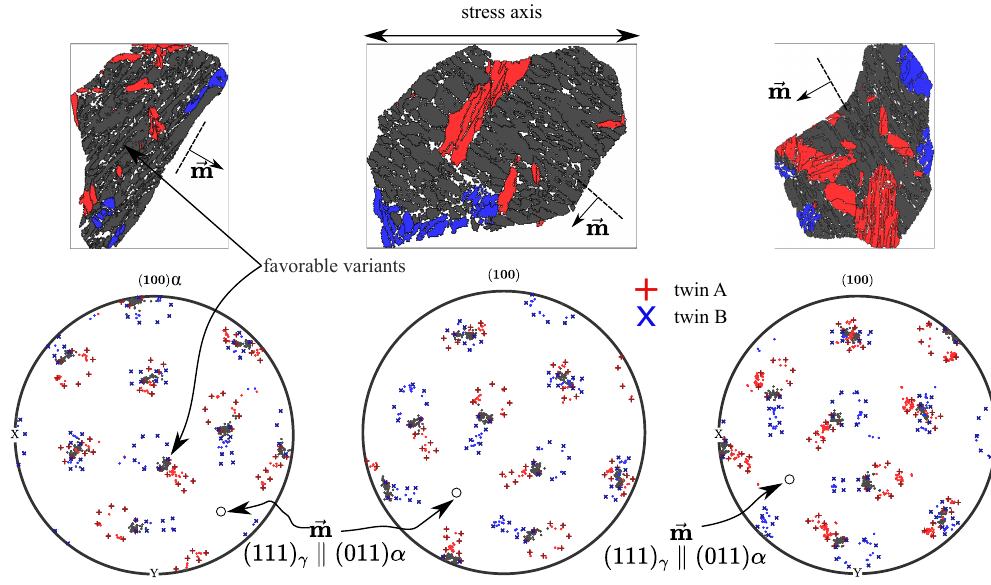
Figure 11. Pole figures for bainitic ferrite sheaves inside individual prior austenite grains; the bainite was formed at 450°C under a tensile stress of 50MPa (Figure 2b). Measured orientations of the sheaves are plotted as fine dots. The calculated variants according to Kurdjumov-Sachs (KS) orientation relationship (OR) are represented by symbols ‘+’ (red) and ‘x’ (blue). The two different symbols distinguish the two twin-related parental austenite orientations. Variants that satisfy the KS OR with only one side of the twins are marked in red or blue, according to their parental orientation. Those six “special” variants that satisfy the OR with both sides of the twins are marked in grey. They share a common close-packed plane that is also parallel to the ( 111 ) γ twinning